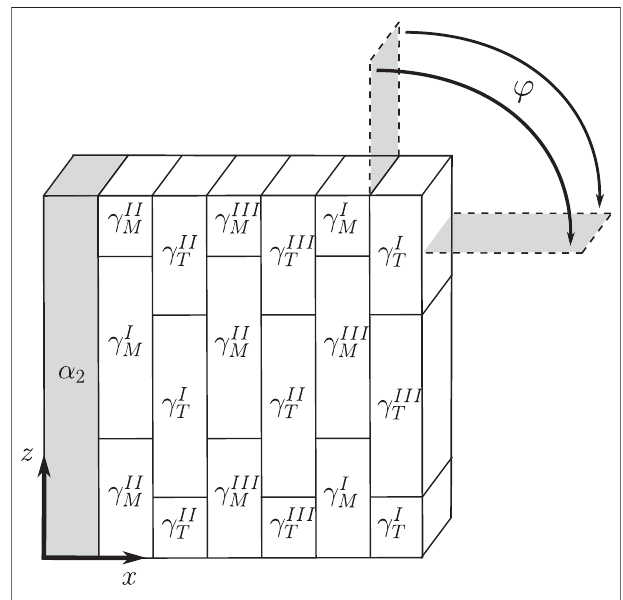
FIGURE 5 | RVE of PST crystal. φ : angle between uniaxial load and lamella plane; c I − III M / T : six orientation variants of γ phase according to Figure 1 (three matrix and three twin orientations). Figure taken from Schnabel and Bargmann